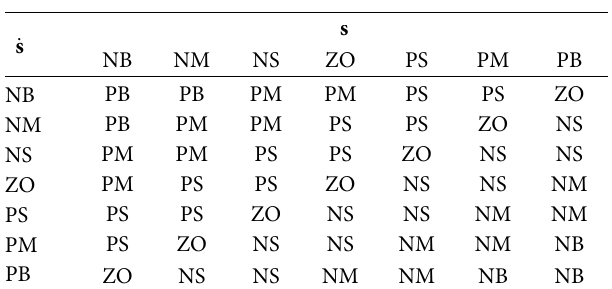
Figure 7: The fuzzy control subsystem. Table 1: Fuzzy rule